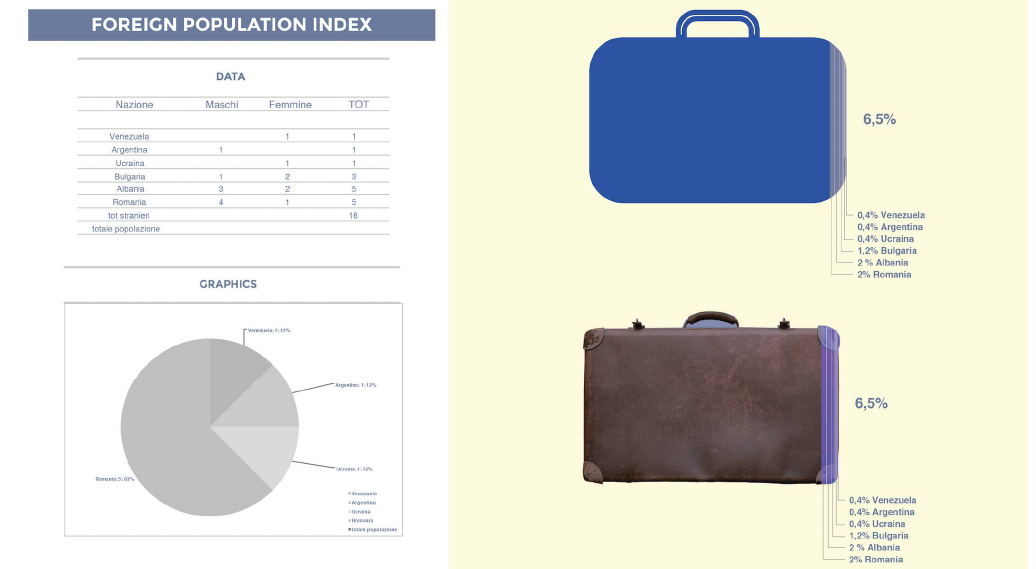
Figure 5. Representing an indicator: foreign population index referring to